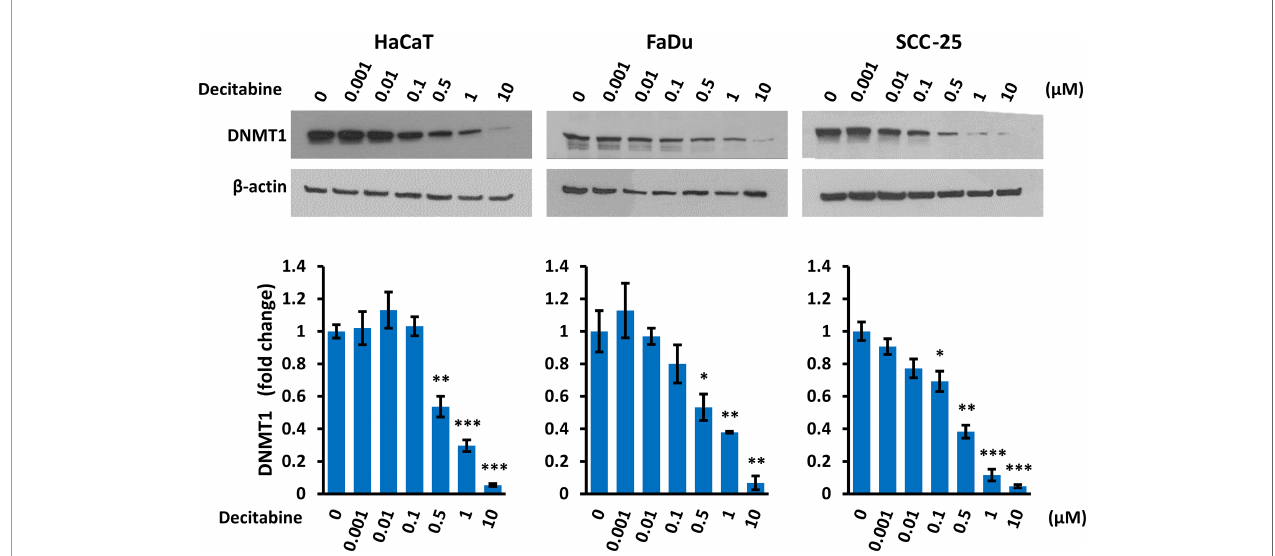
FIGURE 4 | Decitabine decreases DNMT1. Representative Western blots and densitometry of DNMT1 in cells treated with the indicated concentration of decitabine for four days. Data are shown as fold change ± SEM compared to untreated cells (0; DMSO only) and are normalized to b -actin (n = 3 biological replicates for each concentration in each cell line). *p < 0.05; **p < 0.01; ***p < 0.001 compared to control cells.